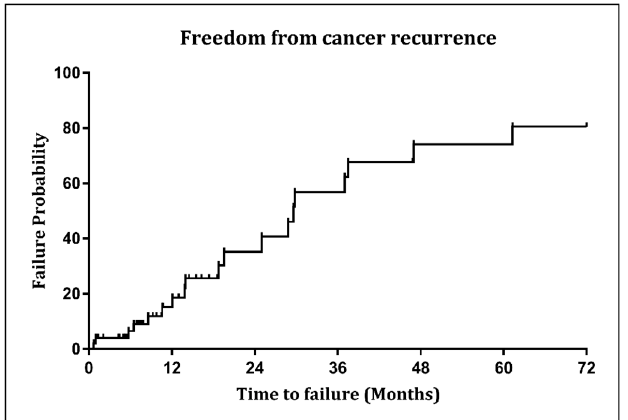
Figure 2. Cumulative incidence method for freedom from cancer recurrence rate in the entire study population.